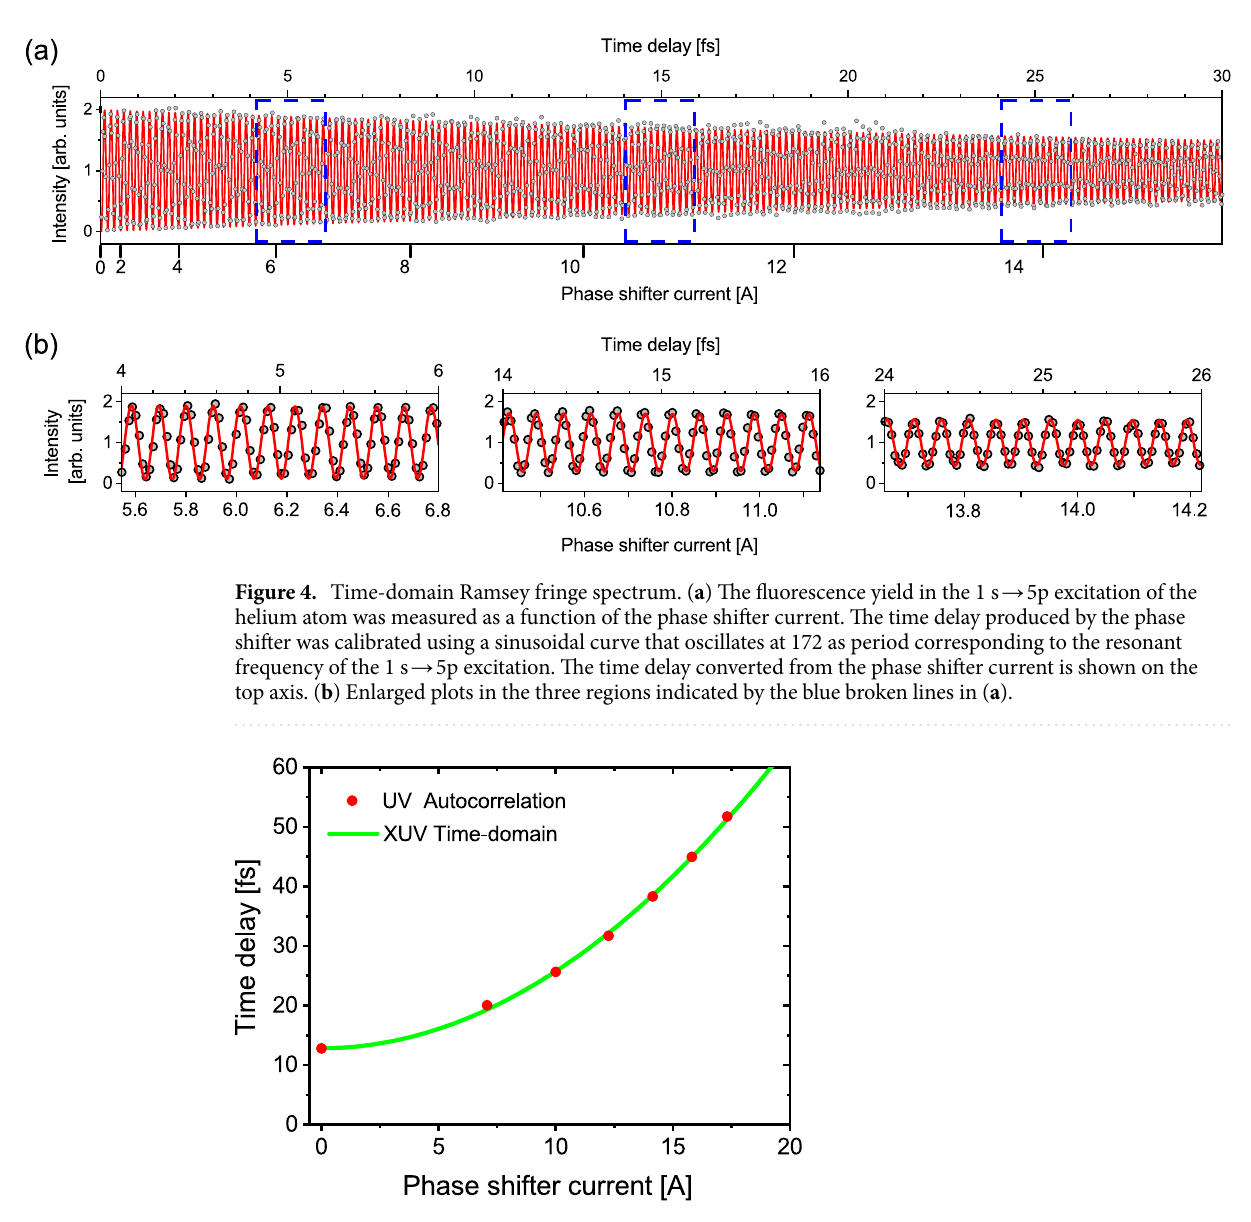
Figure 5. Time delay between the double-pulsed components at 357-nm wavelength obtained by the two different approaches. For comparison, the relative delay obtained in the time-domain interferometry with the XUV wave packets is normalized to the absolute delays in the UV wavelength at 0 A phase shifter